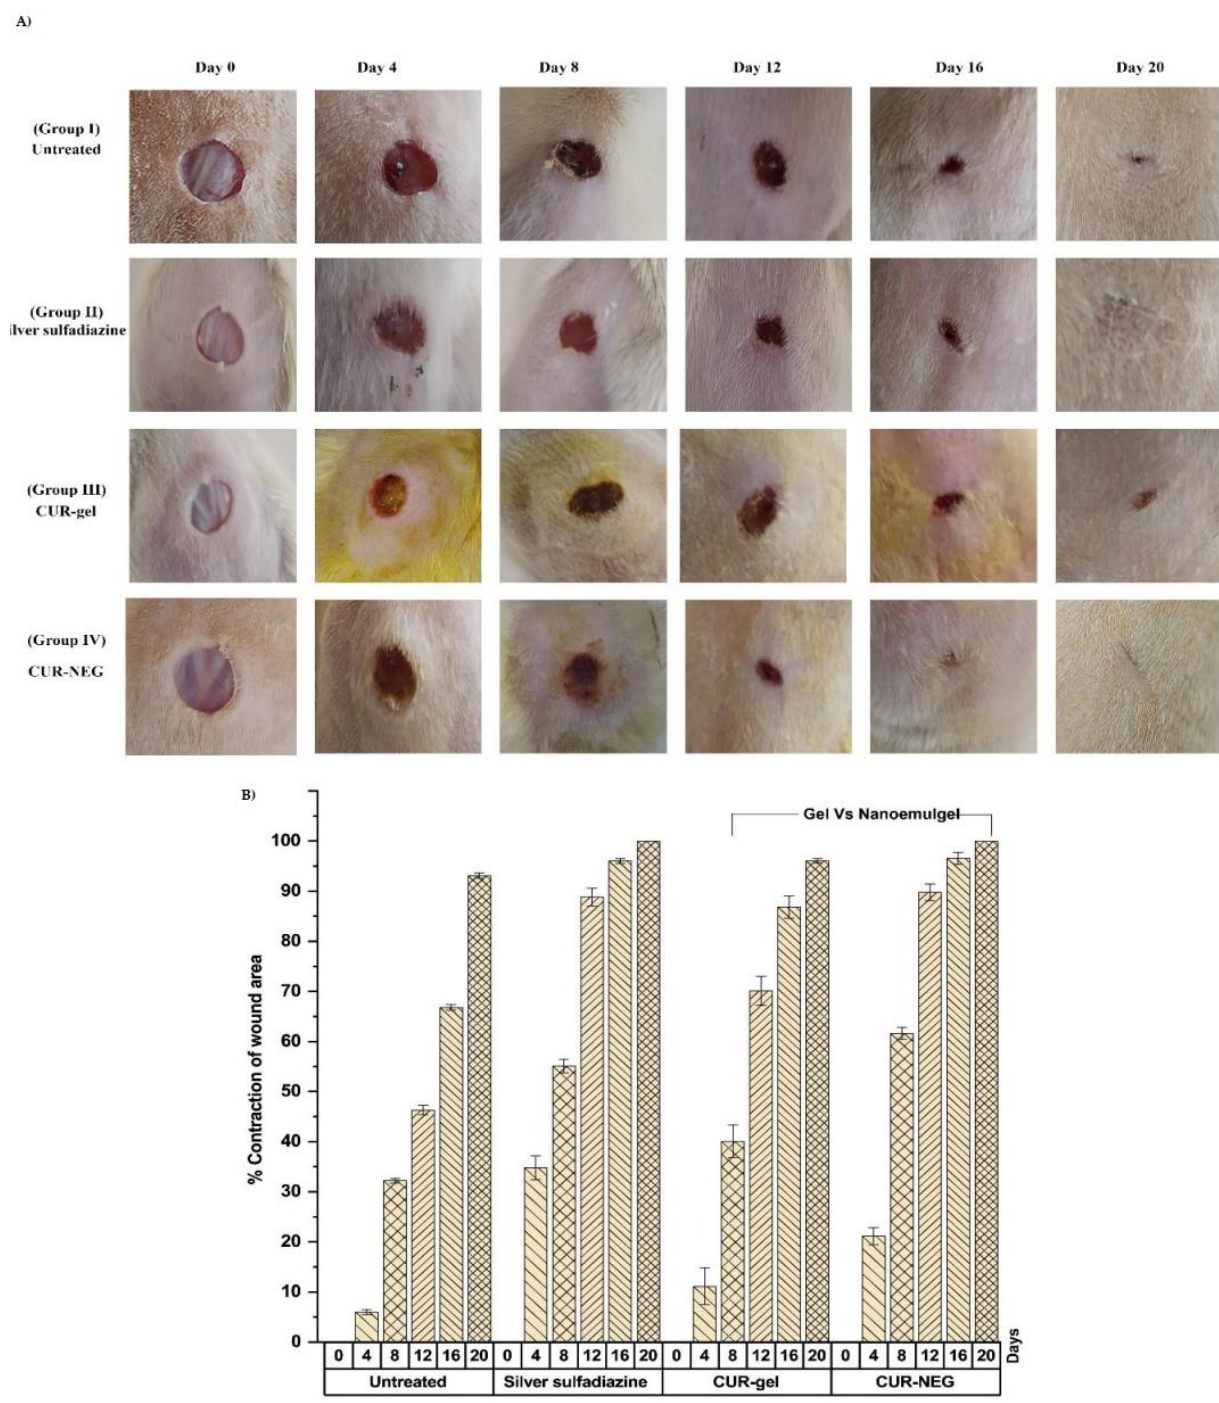
Figure 3. The healing effect was observed by % contraction of wound area over the treatments. ( A ) Representative images of wound healing in Wistar rats; ( B ) Percentage wound area contraction over the treatment. Groups identification: Group I received no treatment; Group II was treated with silver sulfadiazine semisolid formulation; Group III was treated with the hydrogel containing non-encapsulated curcumin (CUR-gel); Group IV was treated with a nano-based hydrogel of curcumin-loaded NE (CUR-NEG). Data are available at 10.3390/gels7040213 [85].